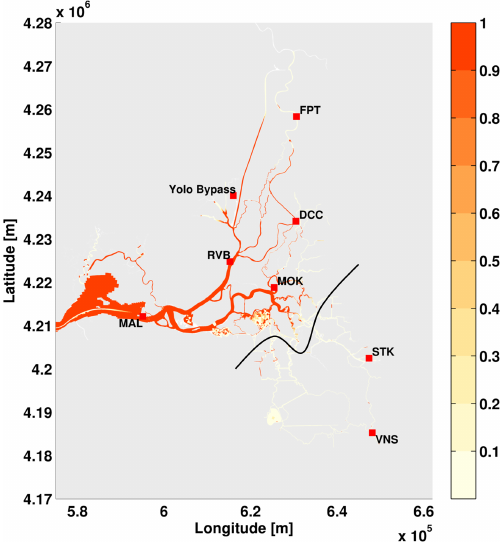
Figure 9. Sediment bottom composition after 1 year, starting with no bed sediment available. Red shades indicate dominance of Sacra- mento River sediments and white shades dominance of San Joaquin River sediments. The black line highlights where this separation oc-